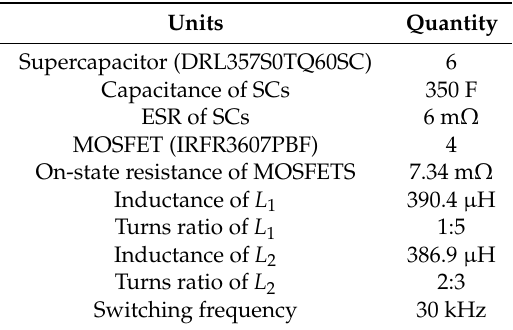
Table 3. Parameters in the